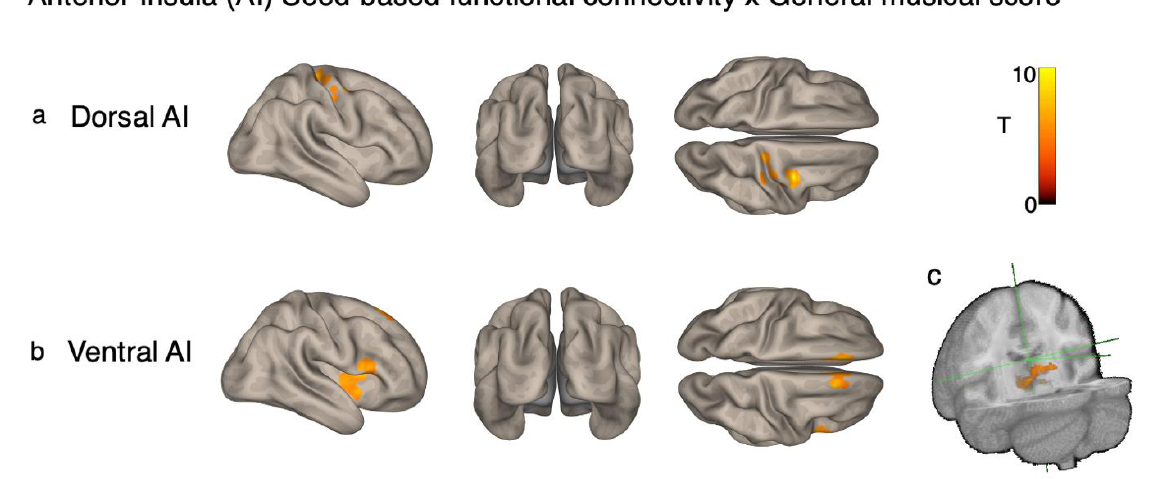
Figure 3. Seed-based connectivity associations with Gold-MSI score. ( a ) Cortical results from dorsal anterior insula seed. ( b ) Cortical results from ventral anterior insula seed. ( c ) Subcortical results from ventral anterior insula seed. Table 1. Insula seed functional connectivity clusters associated with musical score.